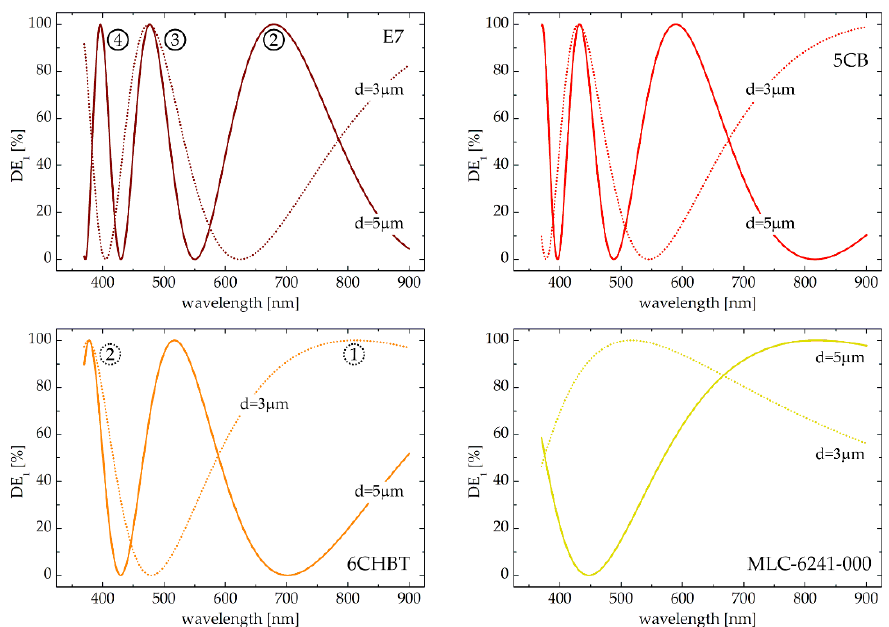
Figure 4. Spectral dependences of the first order diffraction efficiency (DE 1 ) for selected liquid crystalline materials and for two different thicknesses of LC cell ( d = 5 µm—solid lines; d = 3 µm—dotted lines) with no voltage applied. For the fixed cell gaps and specific LC material the obtained result does not depend on the grating period (Λ = 20 µm, 15 µm, 10 µm for d = 5 µm and Λ = 10 µm, 7 µm, 5 µm for d = 3 µm). Maxima are numbered sequentially starting from the longest to the shortest wavelengths, as determined by the condition for the phase retardance.